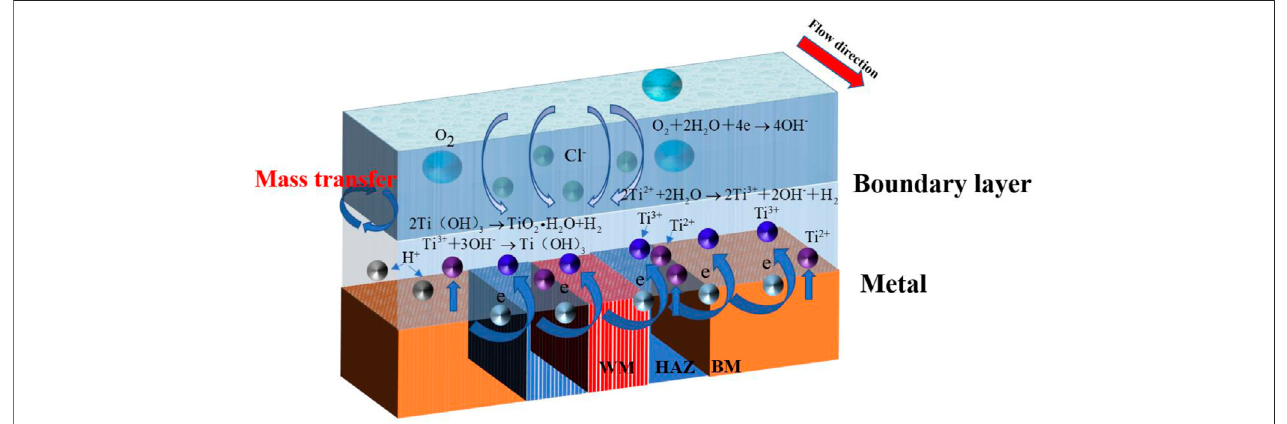
FIGURE 16 | TA2 titanium alloy scouring process of the surface